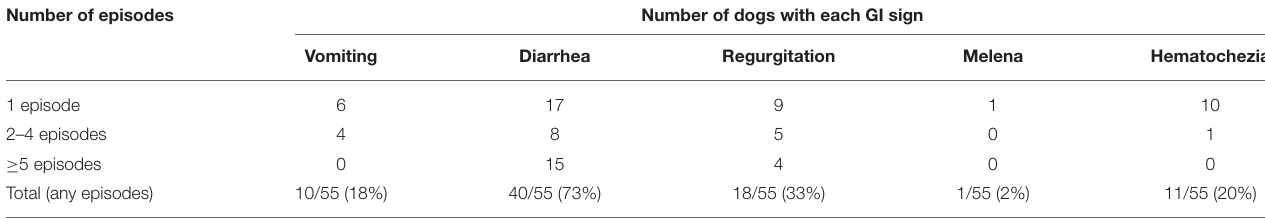
TABLE 1 | Type & frequency of GI signs in 55 of 116 dogs undergoing surgery for TL-IVDE. Number of episodes Number of dogs with each GI sign